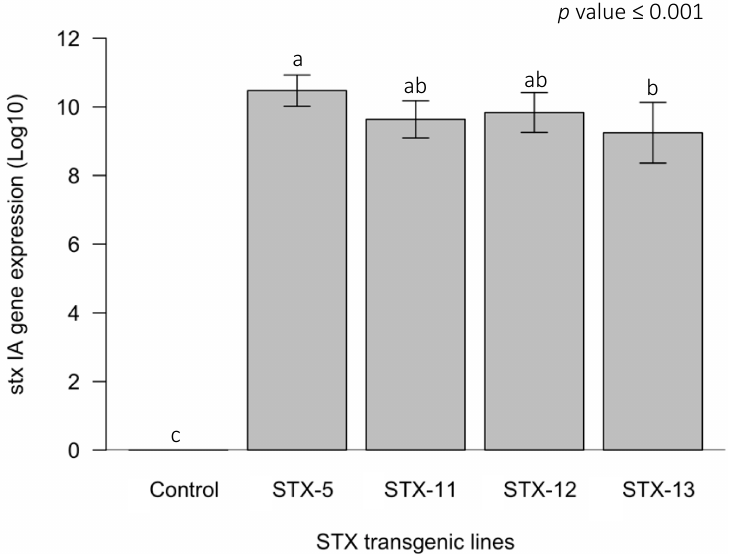
Figure 3. Quantification of the stx IA gene expression (Log 10 ) by the Pera sweet orange transgenic lines STX-5, STX-11, STX-12, and STX-13, based on RT-qPCR test for the cDNA synthesized from extractions of total RNA. A non-transgenic Pera sweet orange plant was included as a negative control. Bars followed by the same letter do not differ according to the Tukey´s test ( p ≤ 0.001).